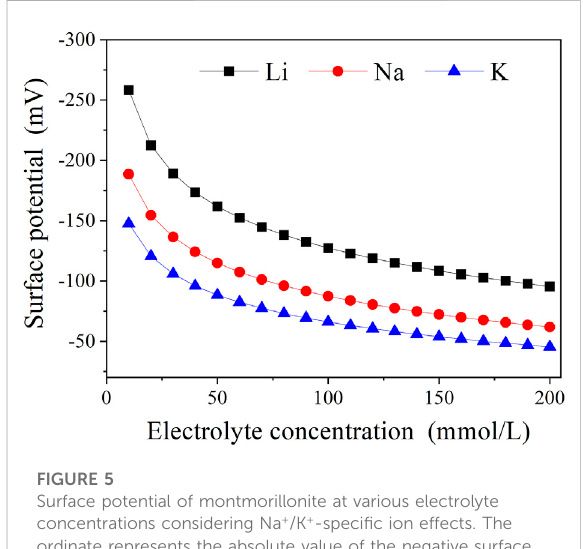
FIGURE 5 Surface potential of montmorillonite at various electrolyte concentrations considering Na + /K + -speci fi c ion effects. The ordinate represents the absolute value of the negative surface potential.